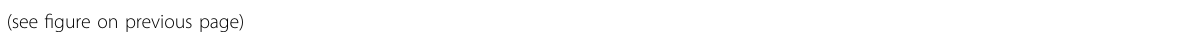
Fig. 8 hnRNPK/ LINC00263 /miR-147a/CAPN2 is a promising target for the development of cancer therapeutics. To expand our fi ndings to various types of cancer, we checked whether the regulatory mechanism of hnRNPK/ LINC00263 /miR-147a/CAPN2 is applicable to various types of cancers. a The relationship between the expression of HNRNPK mRNA and LINC00263 was examined in lung cancer cells by comparing them to the levels in WI-38 cells. The levels of HNRNPK mRNA and LINC00263 in WI-38, H460, and H1299 were determined by RT-qPCR analysis. b To determine whether hnRNPK regulates LINC00263 , the level of LINC00263 was analyzed by RT-qPCR analysis in hnRNPK-silenced lung cancer cells. c Regulation of CAPN2 by hnRNPK and LINC00263 was veri fi ed by assessing the level of CAPN2 mRNA in hnRNPK- or LINC00263 -silenced lung cancer cells. d – h To examine whether hnRNPK/ LINC00263 /miR-147a/CAPN2 axis regulates the invasive and clonogenic abilities, H460 and H1299 cells were transfected with siRNA targeting HNRNPK mRNA or LINC00263 , or pre-miR-147a. The level of CAPN2 protein was determined by Western blot analysis ( d ). Invasiveness ( e , g ) and colony-forming ability ( f , h ) were examined as described in “ Materials and methods ” . i The effect of hnRNPK/ LINC00263 /miR- 147a on CAPN2 expression was evaluated in various cancer cells including DLD1, LoVo, A375P, T98G, and A172. The expression level of CAPN2 and hnRNPK were determined by Western blot analysis. Bars on microscopic images represent 100 μ m. Statistical analyses were performed using